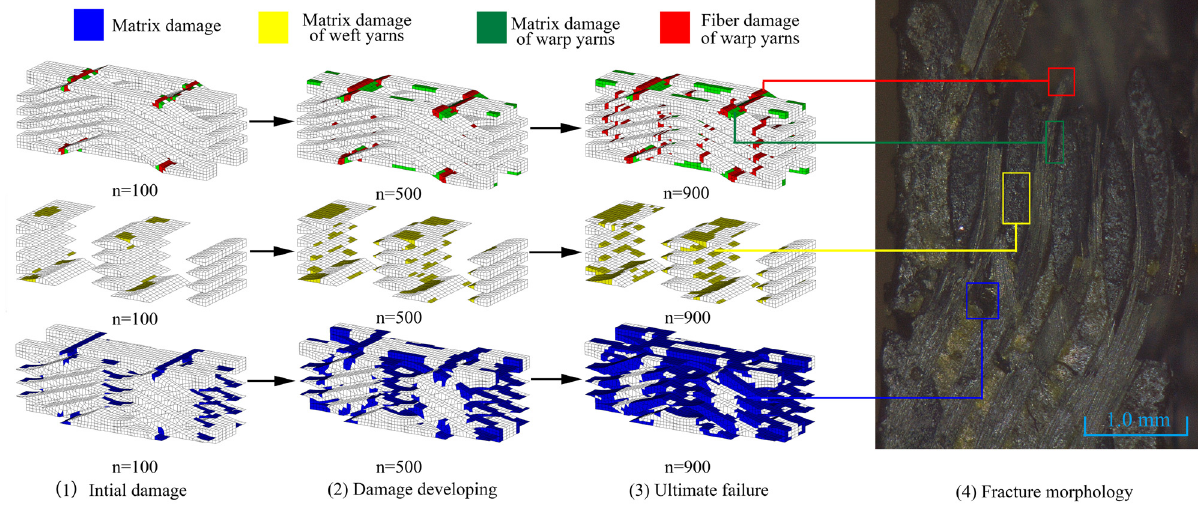
Figure 12: Damage propagation process and experimental fracture morphology of 2.5D woven composites at